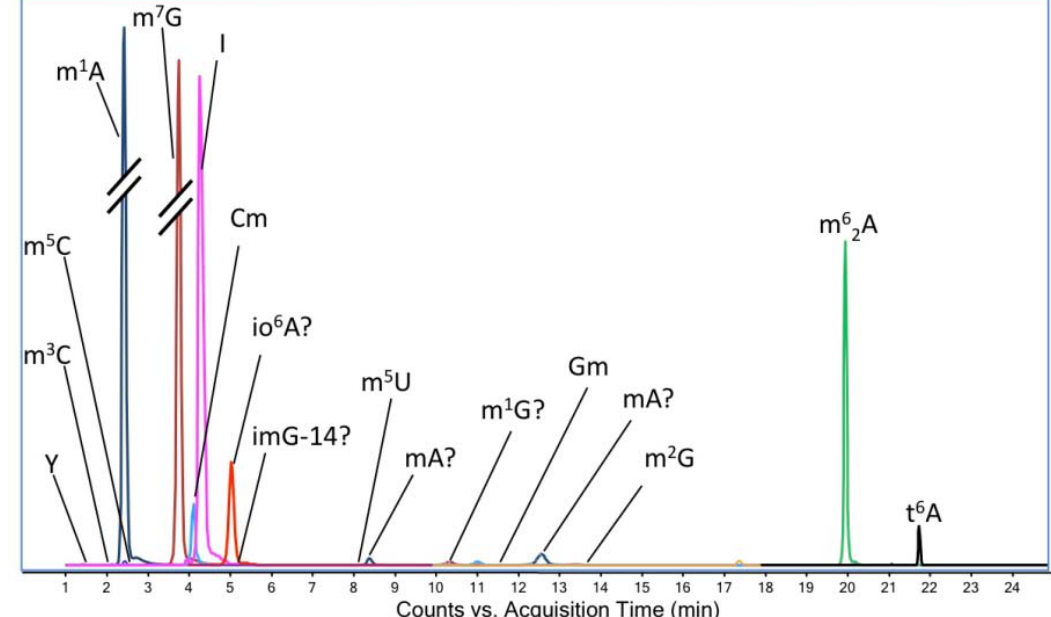
Figure 2. Extracted ion chromatogram of ribonucleoside candidates in hydrolyzed BCG tRNA identified by LC-MS/MS in neutral loss mode. The peaks of m 1 A (2.5 min) and m 7